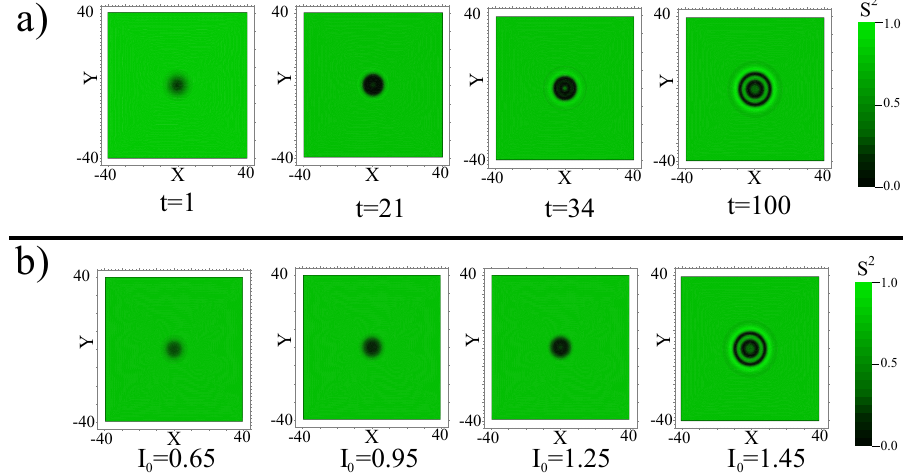
Figure 7. Numerical light-induced ring pattern in a dye-doped nematic liquid crystal using the model in Equation (9). ( a ) Temporal evolution of ring pattern using the effective model in Equation (9) for ˜ A = − 0.5, ˜ B = 0.3, ν = 1.05, b = 0.1, I 0 = 1.45, and w = 4. ( b ) Equilibrium of ring patterns numerically obtained for a different forcing strength I 0 , and the other parameters are ˜ A = − 0.5, ˜ B = 0.3, ν = 1.05, b = 0.1, and w = 4. In brief, the effective model in Equation (9) described the dynamics of the light-induced ring pattern in a dye-doped nematic liquid crystal well in qualitative